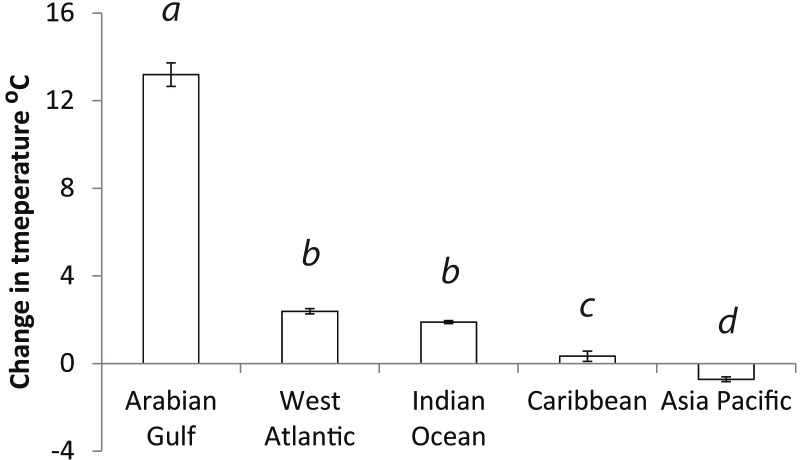
Comparison of the change in air temperatures from the start to end of nesting season in different global regions.Significant difference was found (ANOVA: F4,86 = 560.5, p<0.01). Data from the Arabian Gulf was from the present study and Pazira et al. (2015); data from the Caribbean was collected from Richardson et al. (1999) and Kamel and Delacroix (2007); Indian Ocean data was from Mortimer and Bresson (1999); Asia Pacific data was from Hamilton et al. (2015) and West Atlantic data was from Marcovaldi et al. (1999).